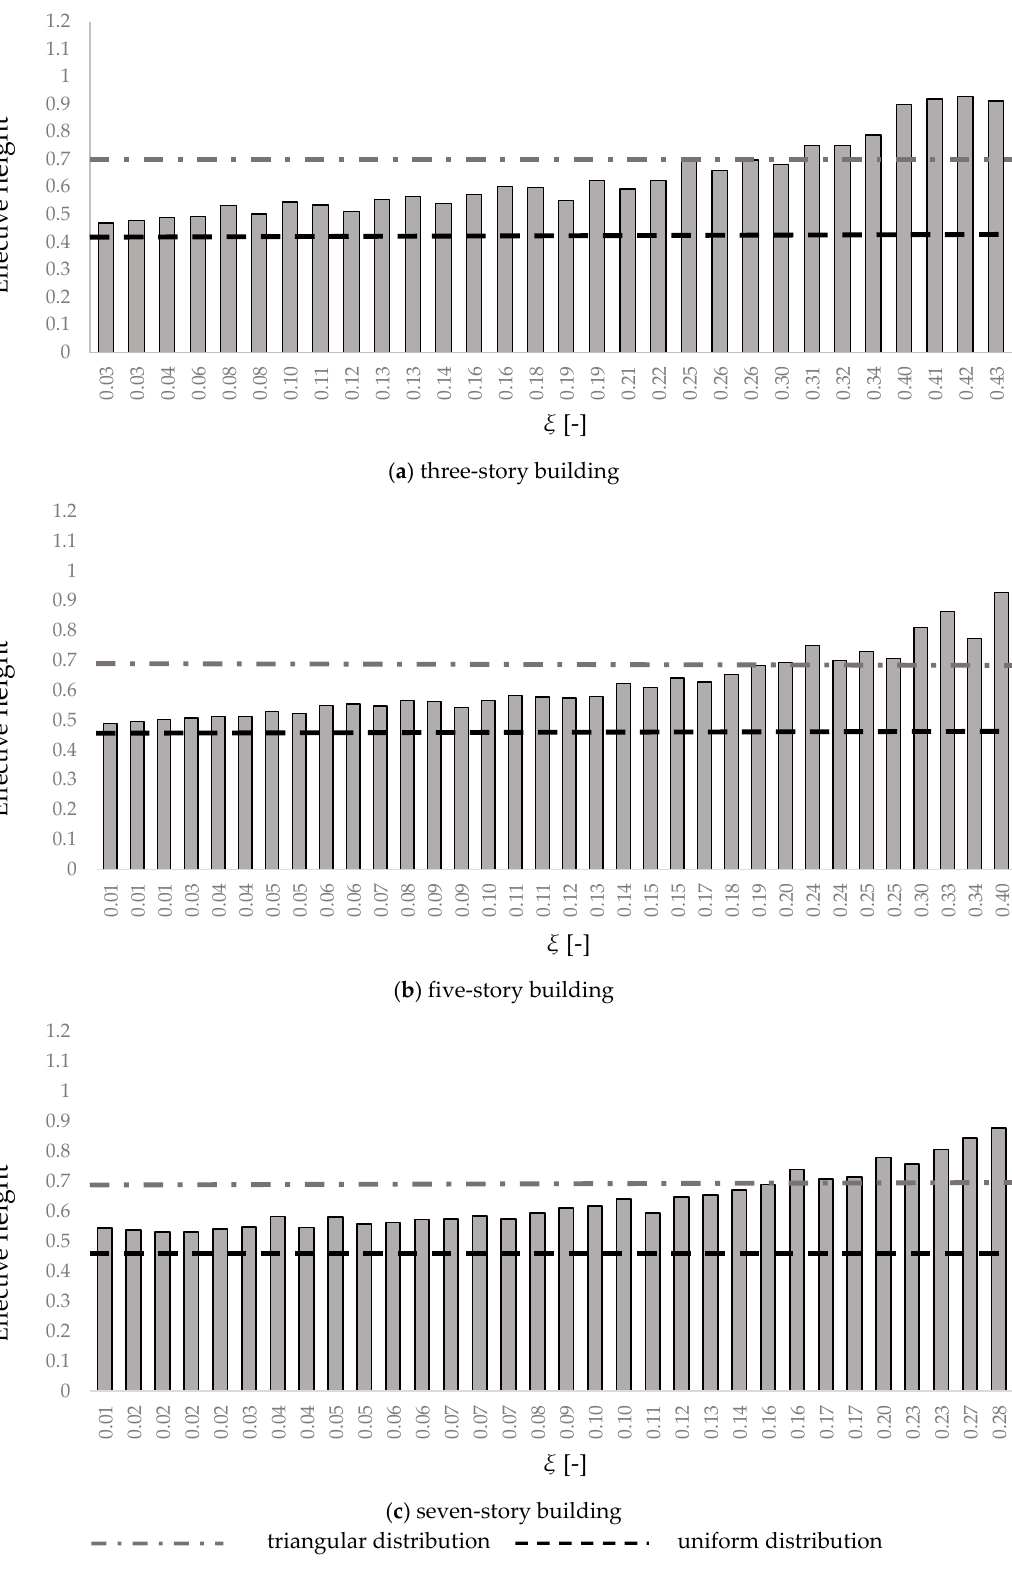
Figure 8. Normalized effective height of the base isolated configurations.